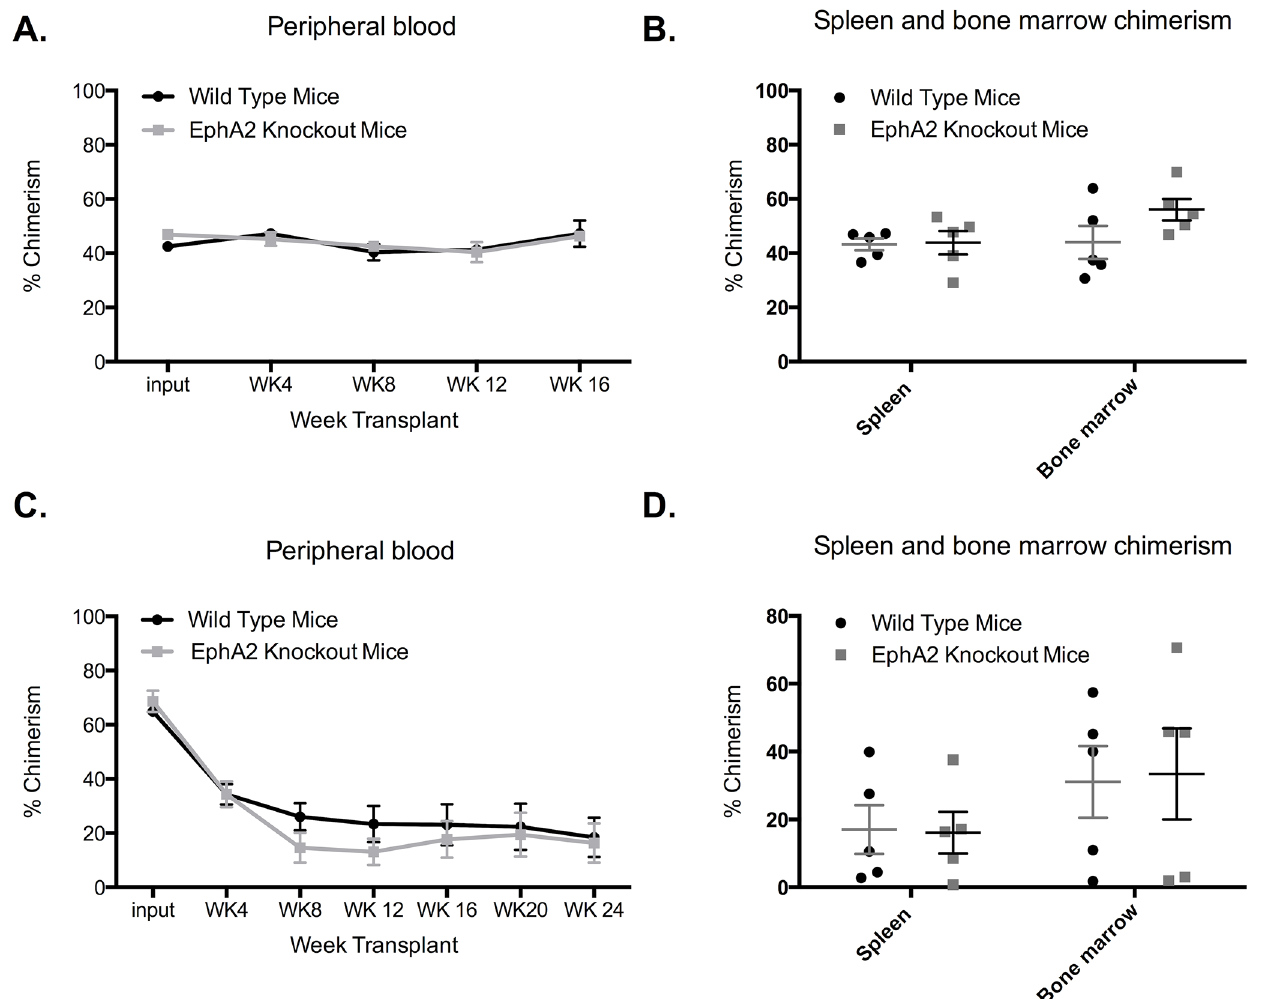
Fig 3. EphA2 knockout bone marrow repopulating potential in primary and secondary recipients. (A) Whole-blood chimerism at 4, 8, 12 and 16 weeks after transplantation of EphA2 knockout or wild type bone marrow cells into lethally irradiated CD45.1 recipients (n = 5). (B) Analysis of bone marrow and spleen chimerism in 16 weeks after primary transplantation. (C) Whole-blood chimerism of secondary transplant at 4, 8, 12, 16, 20 and 24 weeks after transplantation of EphA2 knockout or wild type primary bone marrow cells into lethally irradiated CD45.1 recipient (n = 5). (D) Bone marrow and spleen chimerism analysis 24 weeks after secondary transplantation. Each dot on panel A and C corresponds to mean and error from all wild type or knockout blood chimerism. Each dot on panel B and D corresponds to one individual mouse. The data presented as percentage of blood, bone marrow and spleen chimerism. The data represent mean ± SEM. Unpaired t test was performed for statistical